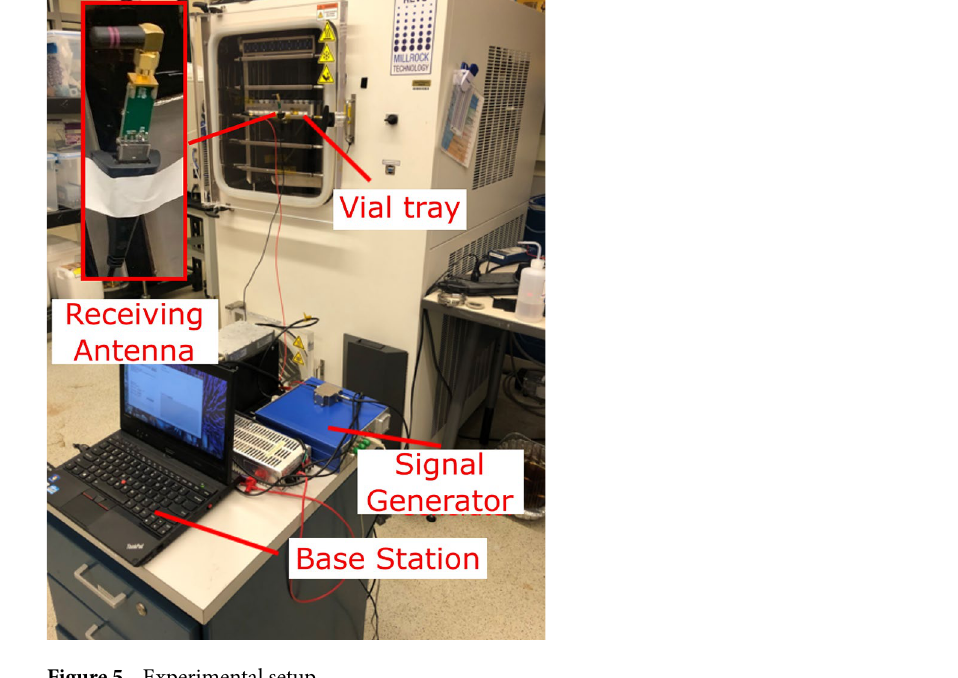
Figure 5. Experimental